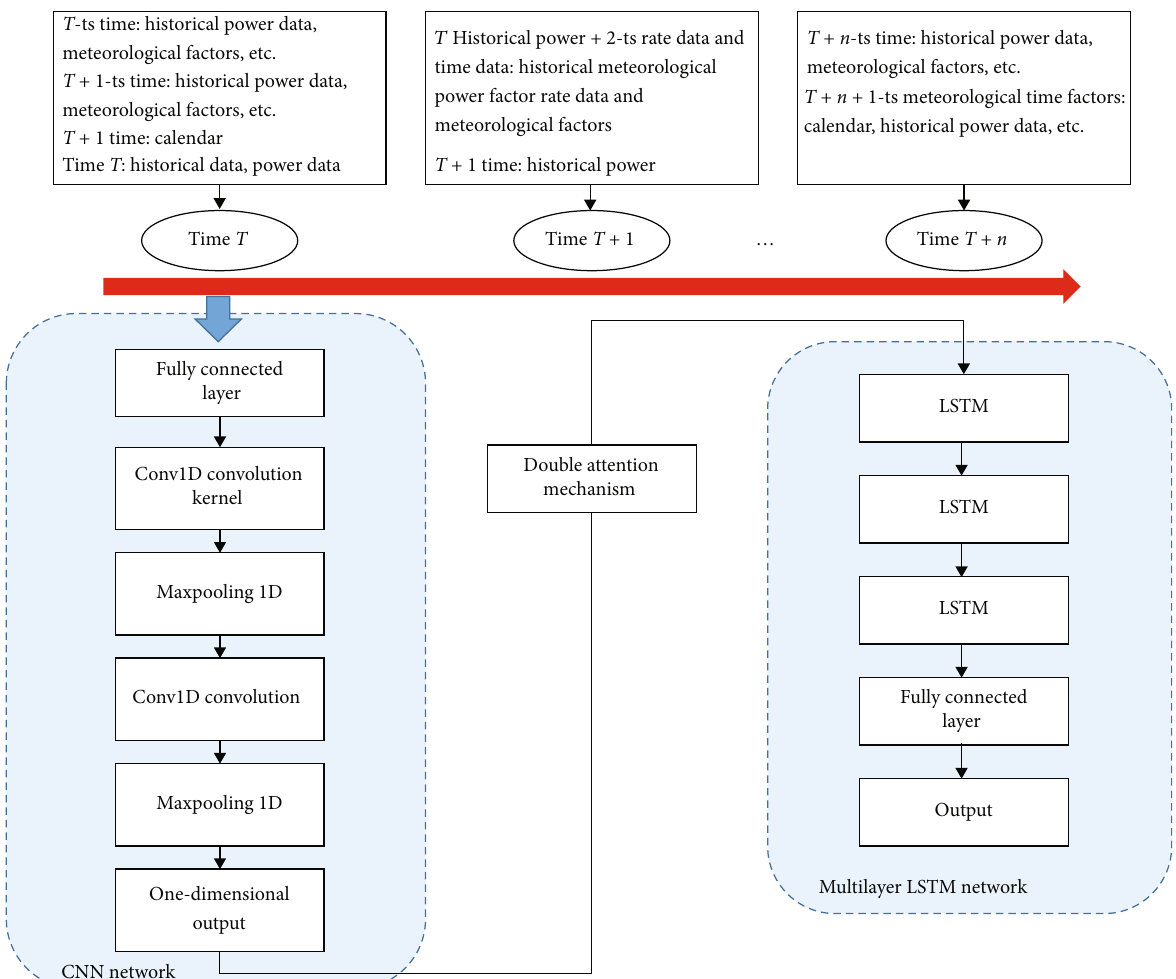
Figure 10: Illustration of hybrid IAM-CNN-LSTM